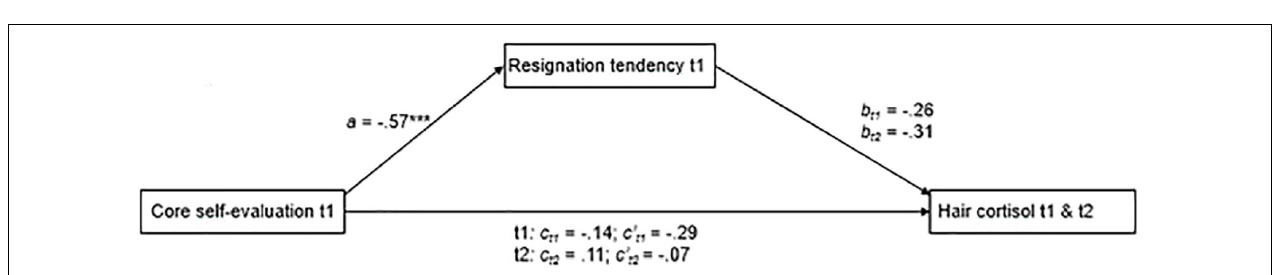
FIGURE 2 | Results of the path-analytical model testing indirect effects of core self-evaluations over resignation tendency on HCC t1 ( N = 39) and t2, accounting for HCC t1 ( N = 36). To simplify the presentation, we standardized the coefficients and omitted error terms and effects of control